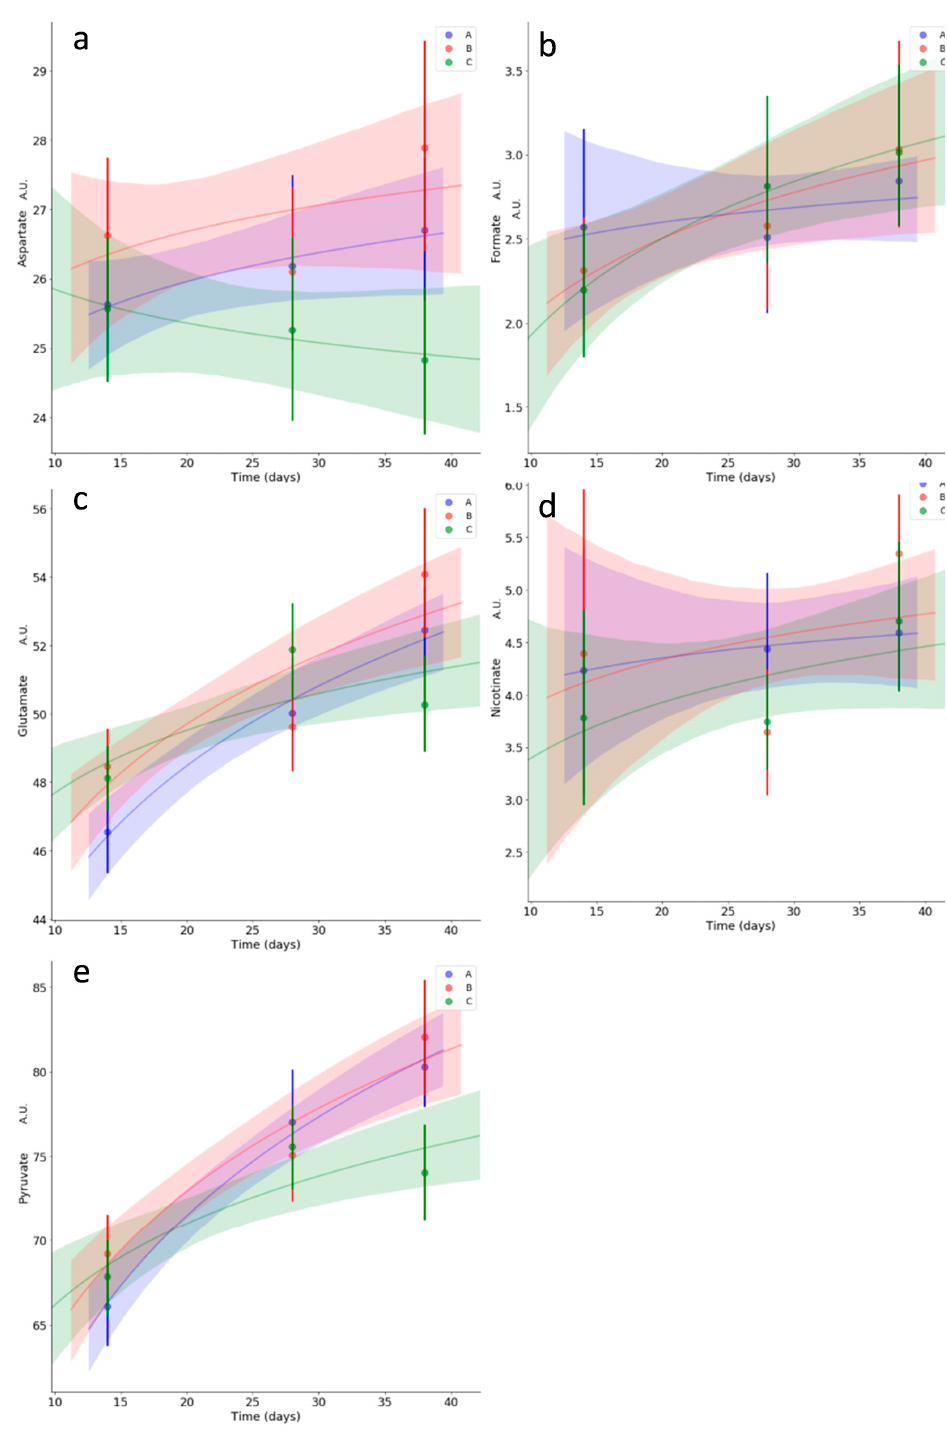
Figure 8. Kinetics for caecal concentration of energy metabolism related metabolites: aspartate ( a ), formate ( b ), glutamate ( c ), nicotinate ( d ) and pyruvate ( e ). Average values for treatment groups A, B and C are reported in blue, red and green, respectively. Translucent bands represent each fit’s 95% confidence interval. Zones of the fits with non-overlapping bands correspond to statistically meaningful di ff erences in trends between groups. Only pyruvate started to show a di ff erent late trend for group C with respect to the other treatments. Metabolites are reported using normalized signal arbitrary units (A.U.), proportional to